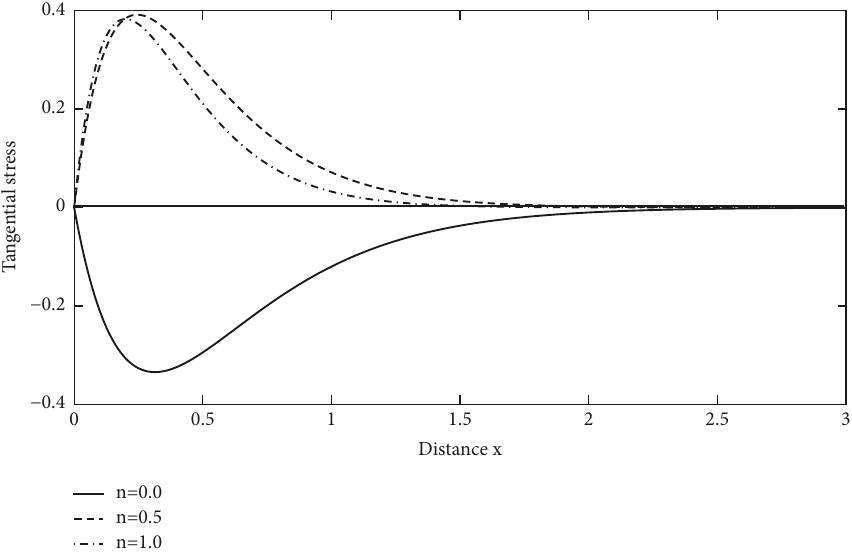
Figure 8: Effect of nonhomogeneity parameter on tangential stress distribution.